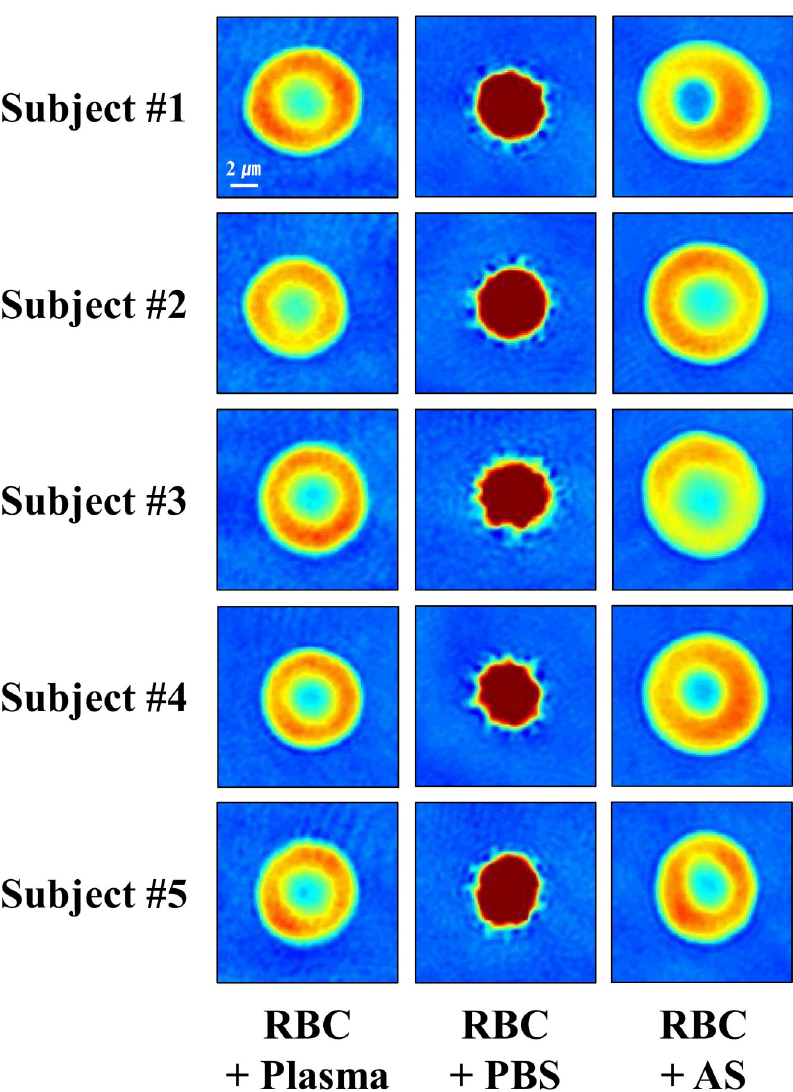
Fig 1. 2D images presenting the morphology of RBCs in the conventional solutions. RBC, red blood cell; PBS, phosphate-buffered saline; AS, Alsever’s